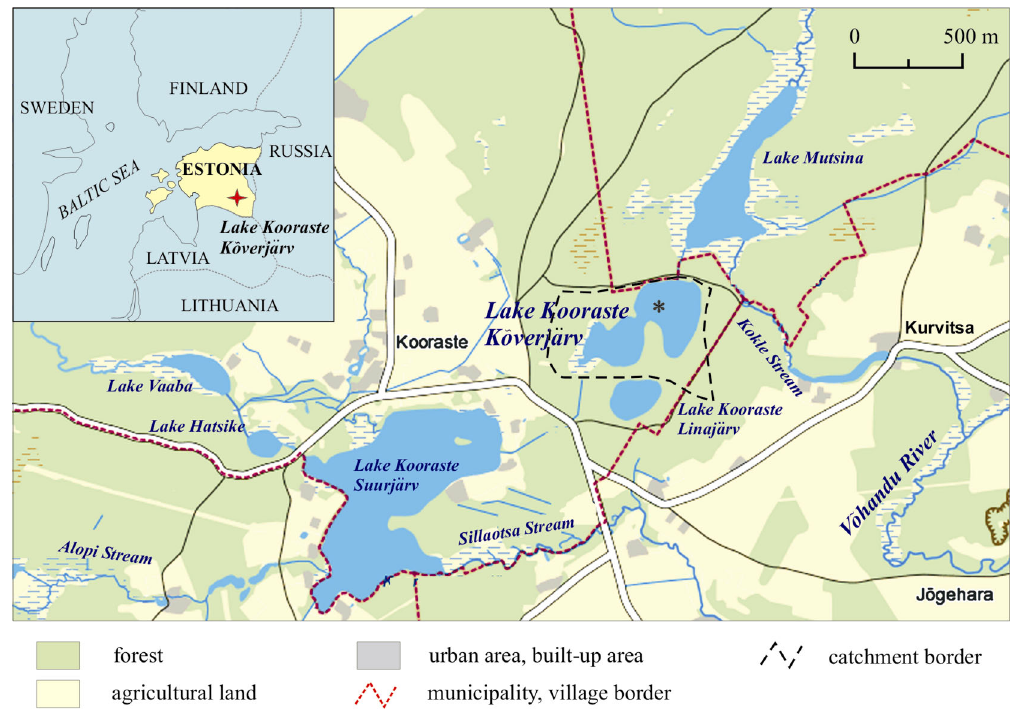
Fig. 1. Location map of Lake Kooraste Kıverj(cid:228)rv and its surroundings. The coring site is indicated with a black asterisk and the catchment border with a dashed line. Modified fragment of the map from Land Information Web Map Application of the Estonian Land Board